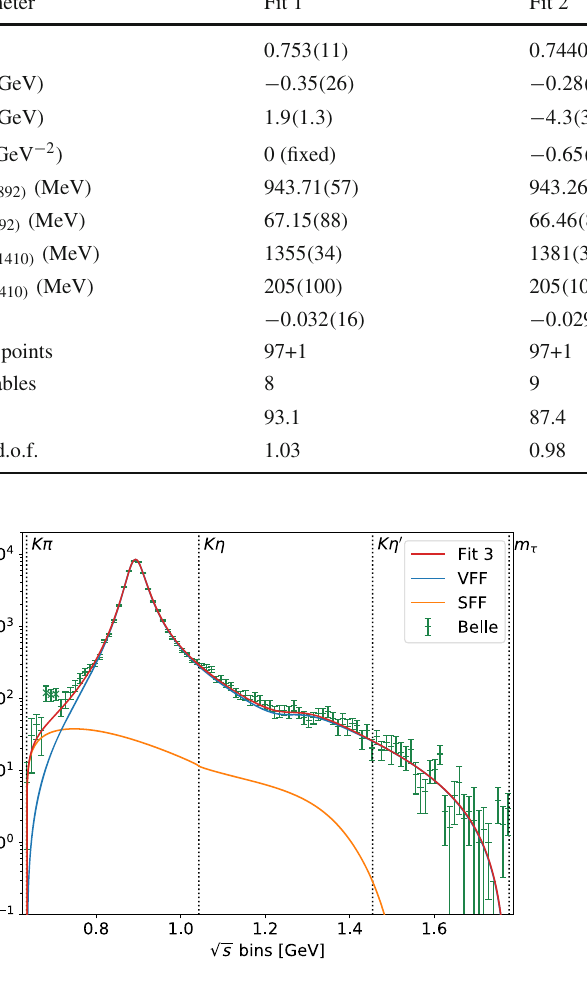
Fig. 4 Example result Fit 3 for the fit of theoretical events N , defined in Eq. (23), to efficiency-corrected and background-reduced events for τ − → K S π − ν τ of Ref. [65] including the additional constraint of Eq. (33). In addition, we show the scalar form factor (SFF) and vector form factor (VFF) components separately